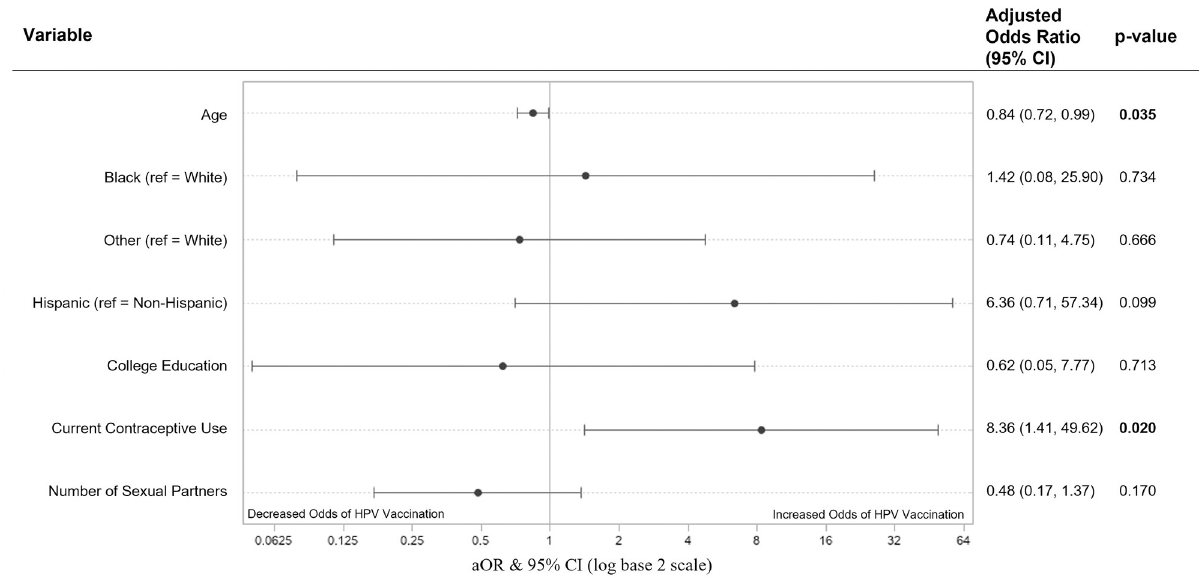
Fig 1. Predictors of HPV vaccination in multivariate logistic regression (model 1, n = 84). Predictors of HPV vaccination in a multivariable logistic regression model containing age, race, ethnicity, educational attainment, current contraceptive use, number of sexual partners, and HPV score. Adjusted Odd Ratios of adverse events were calculated and presented using a log base 2 scale in a Forest Plot. Null line is indicated for no predictor effects and bolded lines represent adjusted odds ratio with 95% confidence intervals. Bolded lines above and below the null line indicate increased or decreased odds of adverse events,